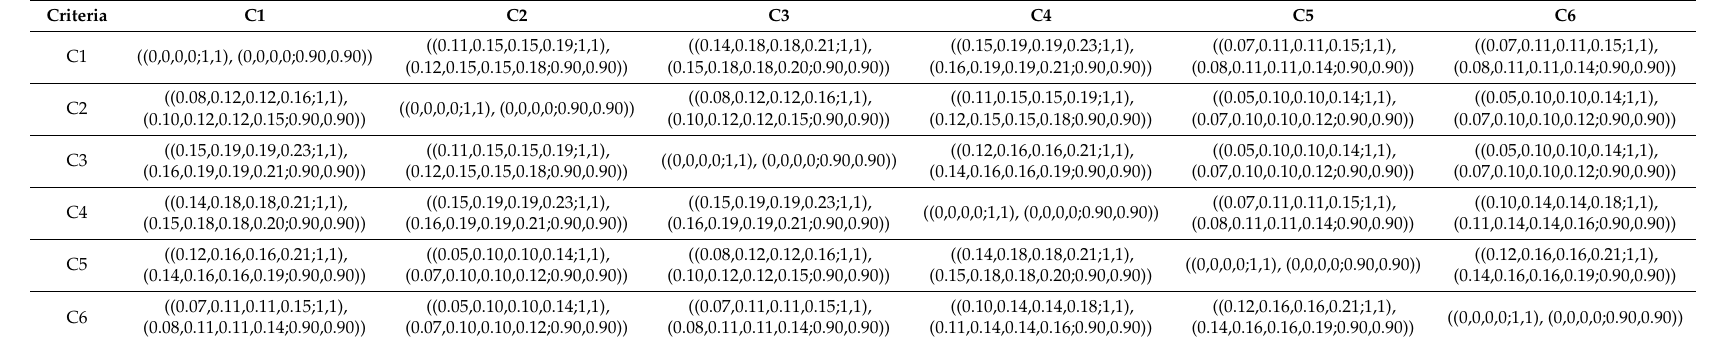
Table 7. The normalized